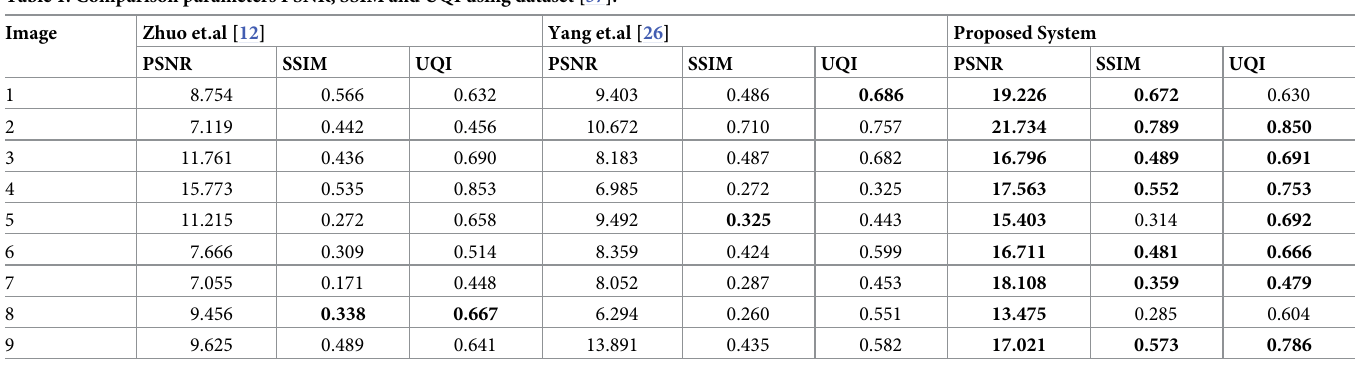
https://doi.org/10.1371/journal.pone.0217246.t001